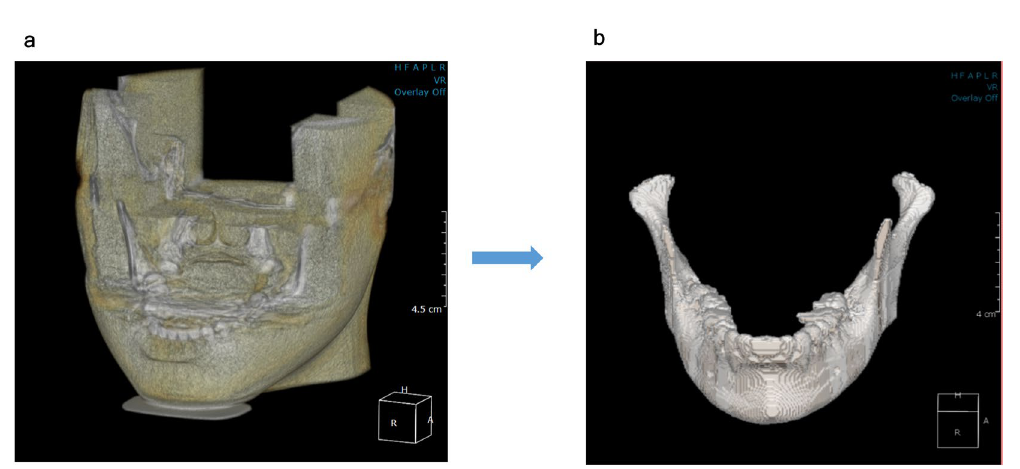
Figure 5. Binarization of the mandible. ( a ) Representation of the processed 3D CBCT image. ( b ) The 3D images were binarized using Otsu’s method and the cumulative binarization algorithm until reaching the upper points of the condylar head obtained in the previous step of removing the upper portion of the bilateral condylar heads (Fig. 3d). 3D, 3-dimensional; CBCT, cone-beam computed